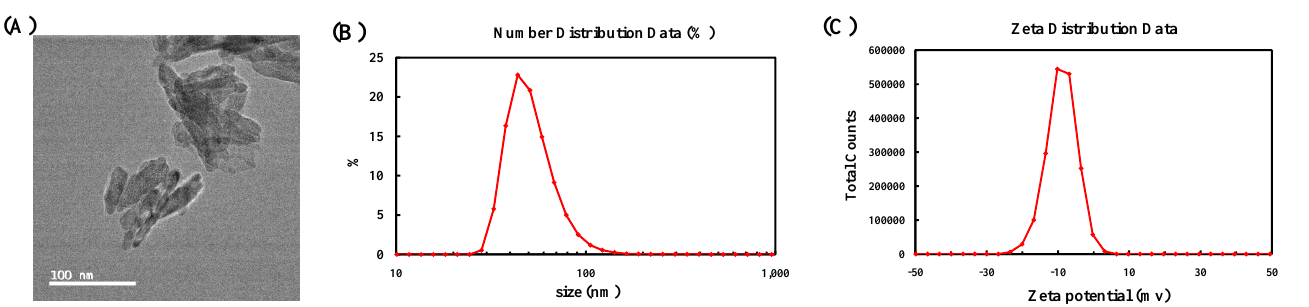
Figure 2. Typical TEM image of MTX-PEG-nHA ( A ) and its hydrodynamic size ( B ) and zeta potential ( C ).